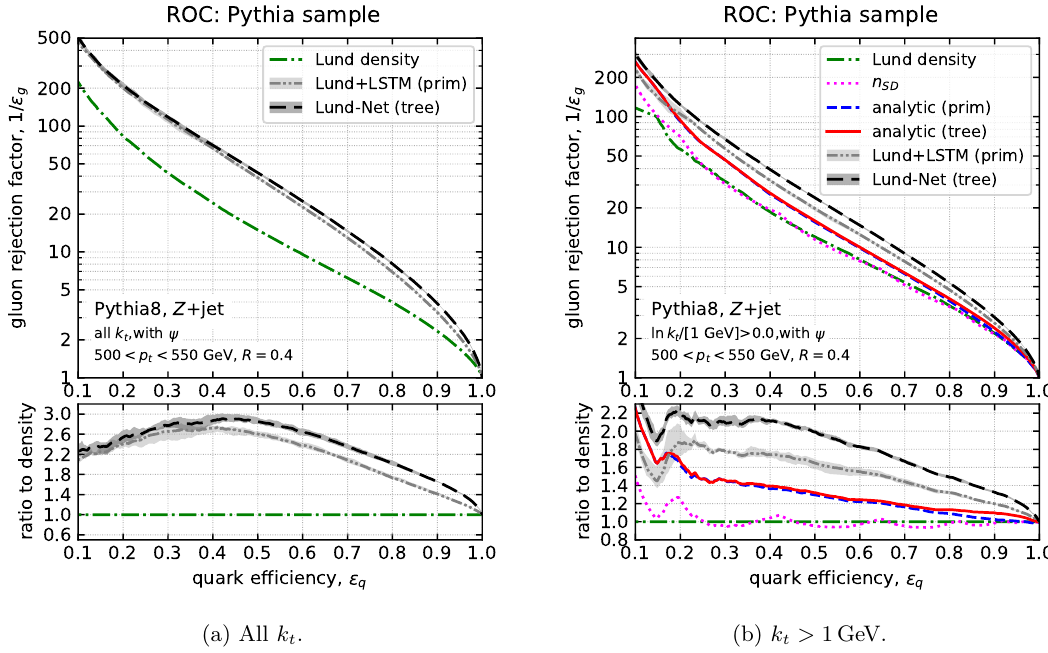
Figure 7. ROC curves corresponding to the AUC showed in figure 6. The left plot corresponds to all Lund declustering being included while for the right plot a k Since the methods anchored in perturbative QCD are meant to be effective in the region where perturbative QCD applies, they are only shown on the right